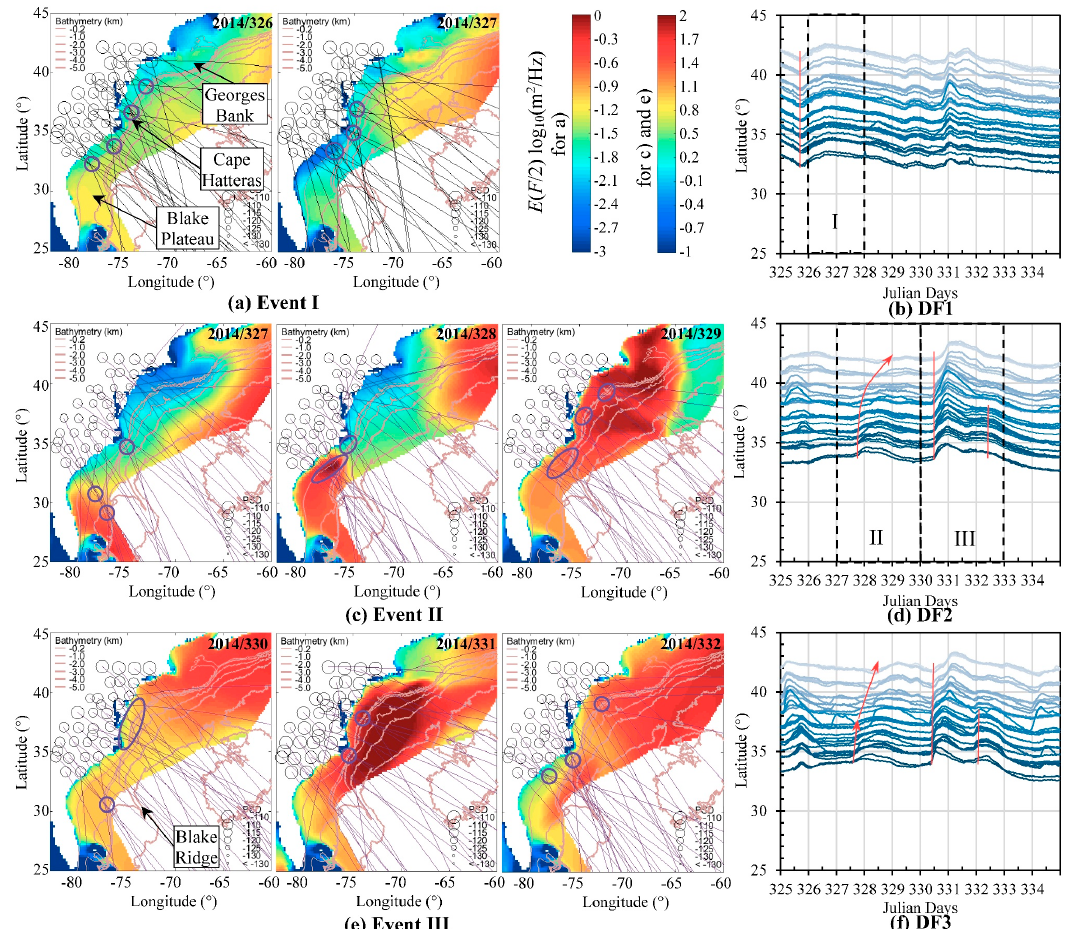
Figure 4. ( a , c , e ) Daily WAVEWATCH III hindcasts of ocean wave spectra ( E ( F /2) in log10 (m 2 /Hz)) in Northern Atlantic Ocean (color gradient maps), PSD levels (small circles with scaled sizes), and primary vibration directions (segments of great circles) at all stations corresponding to the three events (I, II, and III) identified in Figure 2. The purple circles/ellipses delimit the intersections of the great circles; ( b , d , f ) Time history of average PSDs in three frequency bands. In each plot, the curves are stacked by the latitudes of the stations and the relief of each curve shows the change of PSD level. The starting time of the three events are picked and connected to form the red lines, the arrows of which show the impact sequence.